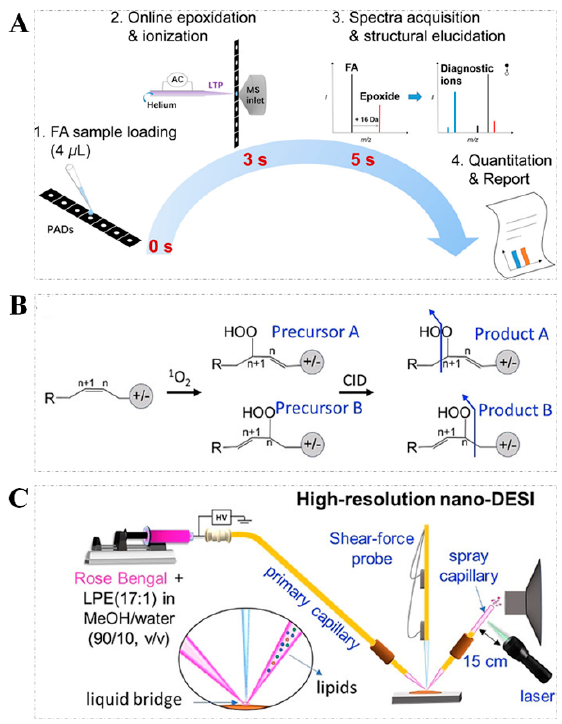
Figure 5. ( A ) The workflow of online epoxidation/ionization of unsaturated FAs on paper strips by LTP − MS (reproduced permission from Ref. [55]. Copyright (2018) American Chemical Society); ( B ) the mechanism of C = C bond oxidation by 1 O 2 and fragmentation via CID to yield products; ( C ) the experimental setup of online 1 O 2 derivatization of C = C bond combined with nano − DESI − MS (note: Figure 5B,C, reproduced from Ref. with permission from permission of Wiley-VCH GmbH).